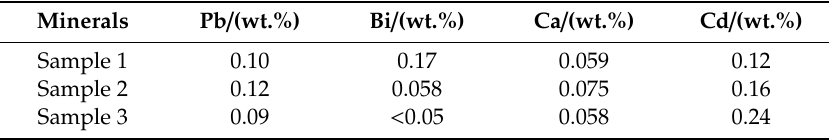
Table 2. Inductively coupled plasma massspectrometry (ICP) of sphalerite